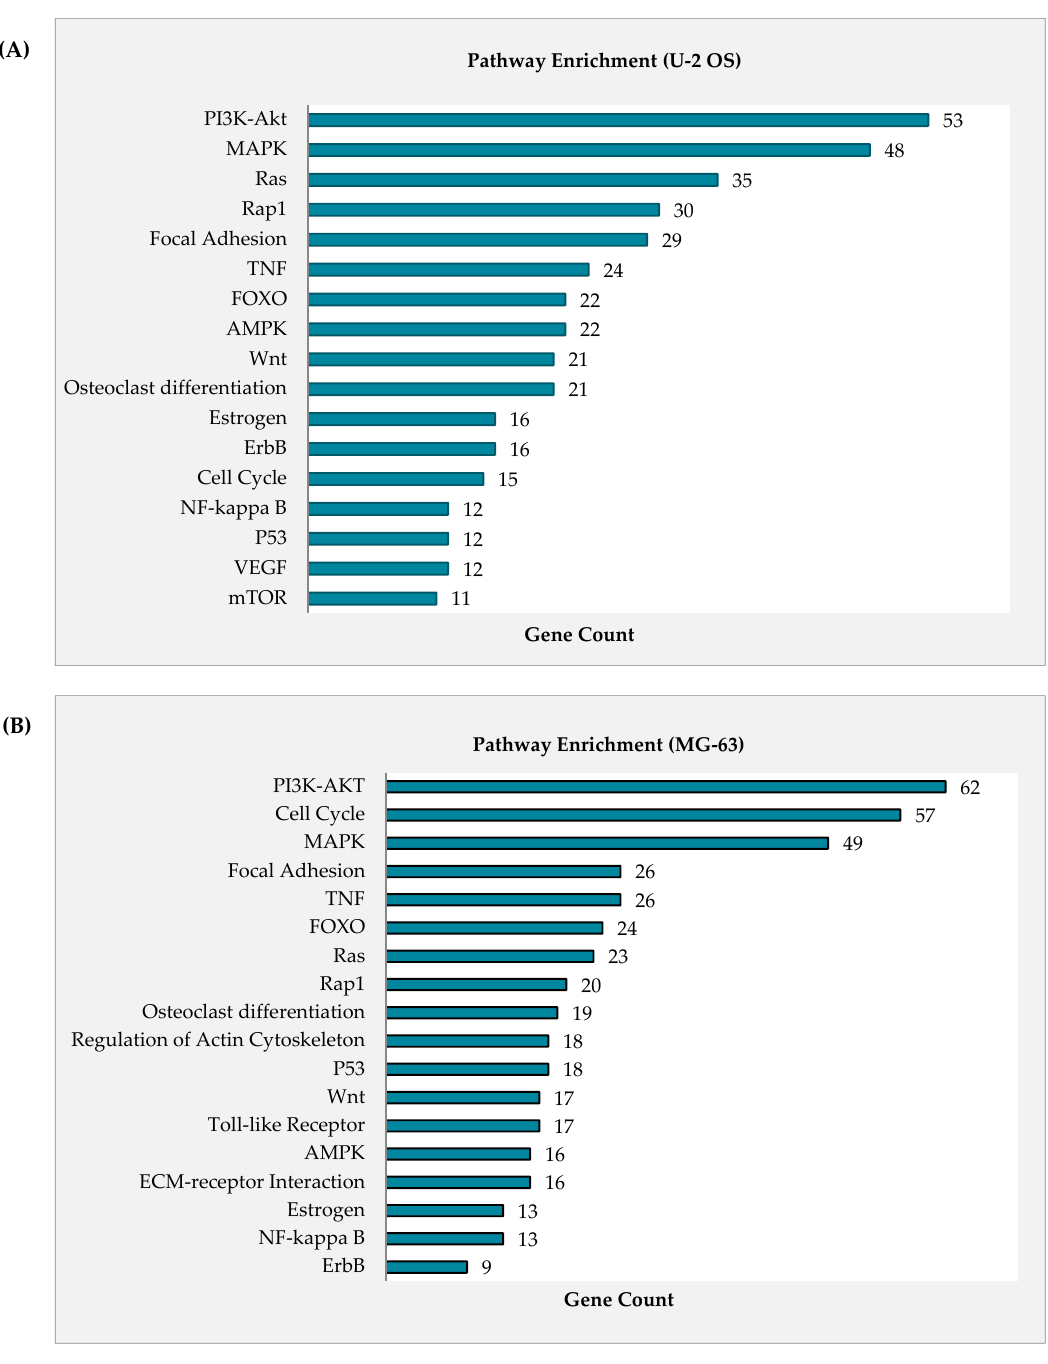
Figure 5. ( A , B ) Exhibited the enrichment pathway in cancer that is associated to the regulated expression genes for both U-2 OS and MG-63 osteosarcoma cell lines. All characterized pathways were selected based on the gene count numbers with p value < 0.05.